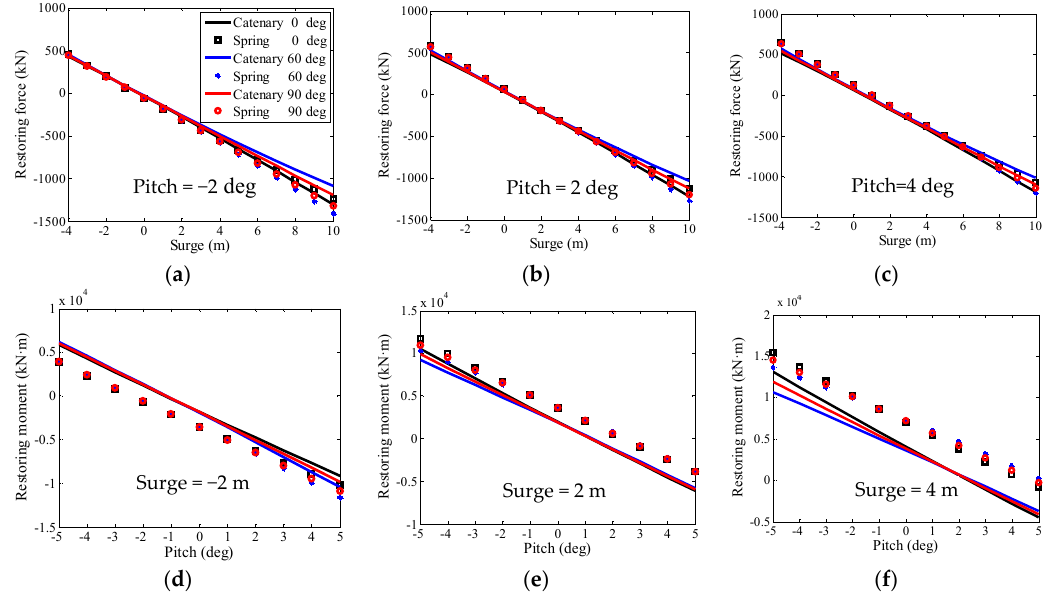
Figure 6. Surge-restoring force curves with pitch motion: ( a ) pitch= − 2 deg; ( b ) pitch = 2 deg; ( c ) pitch = 4 deg and pitch-restoring moment curves with surge motion: ( d ) surge = − 2 m; ( e ) surge = 2 m; ( f ) surge = 4 m.